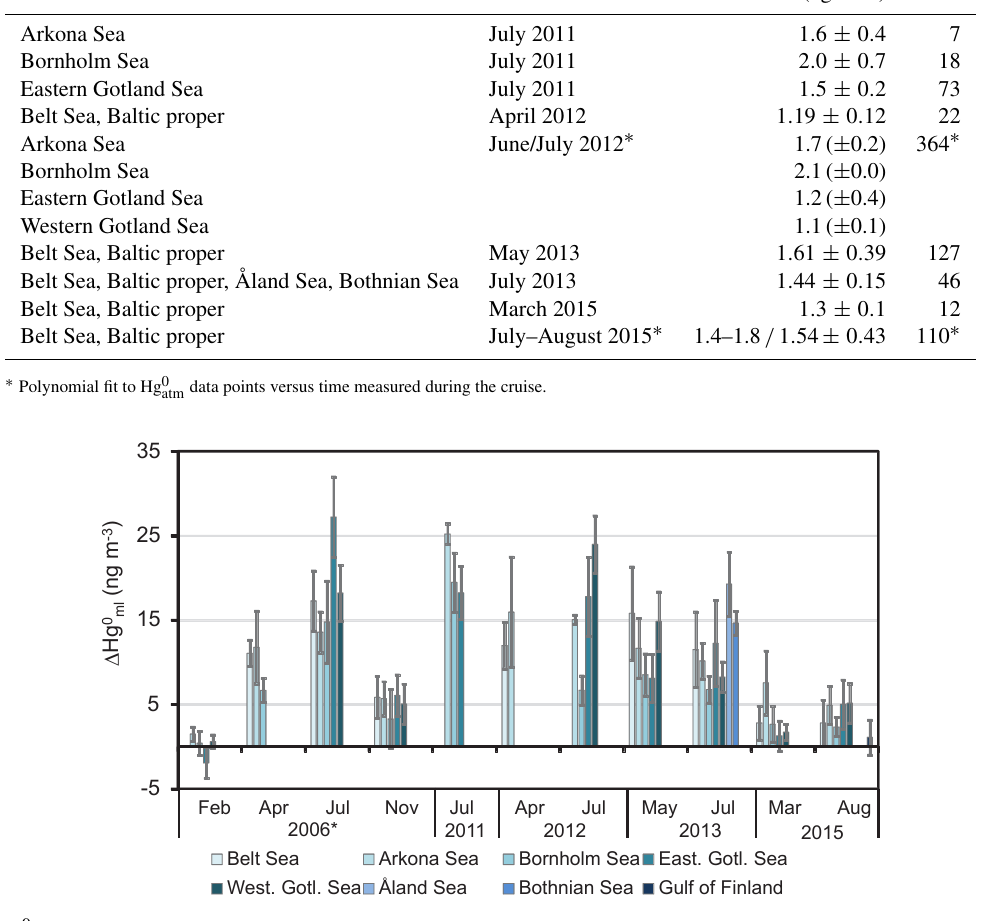
Figure 4. The Hg 0 sea–air concentration difference that determined the flux is given for the different sea areas (see map in Fig. 1) during the cruises of this study (2011–2015). ∗ For comparison, data from a 2006 study (Kuss and Schneider, 2007) are